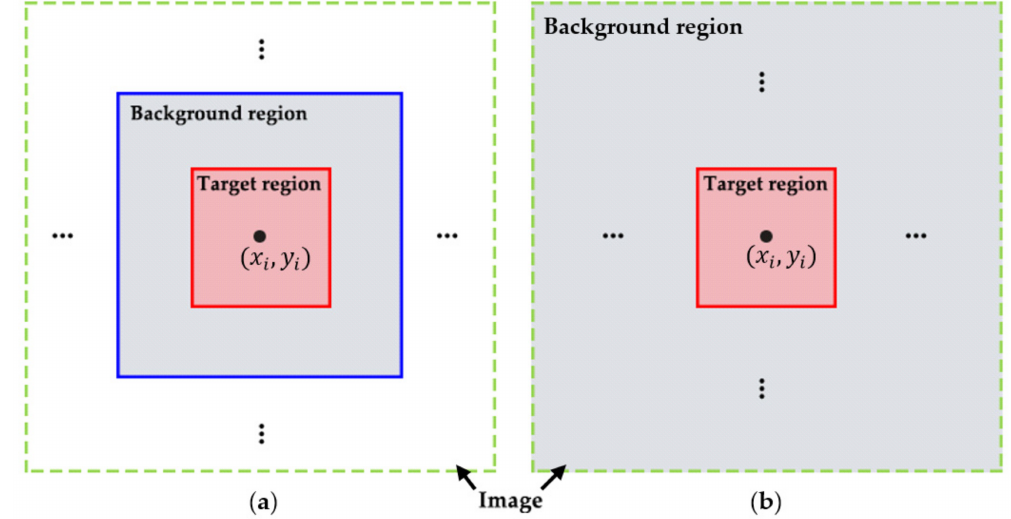
Figure 1. Target and background regions (salient and nonsalient regions) used for the estimation of two probability density functions (PDFs). ( a ) Regions for the calculation of the local saliency measure; ( b ) Regions for the calculation of the global saliency